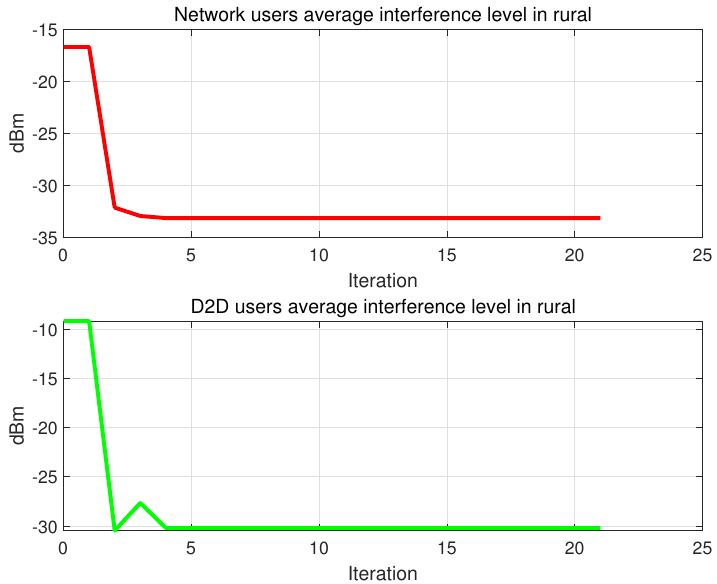
Figure 15. Mean interference level in rural environment along GADIA iterations.